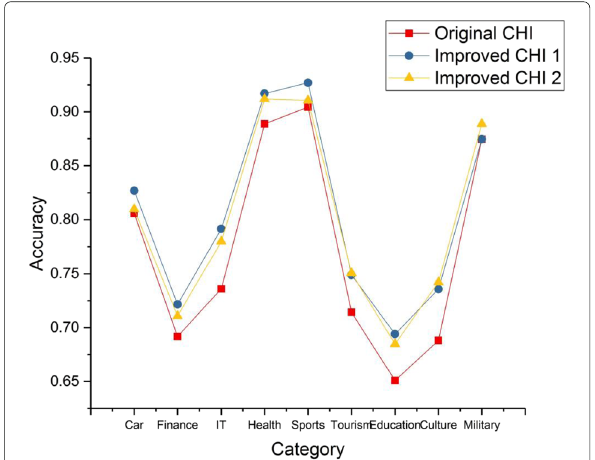
Fig. 3 Classification results comparing three kinds CHI